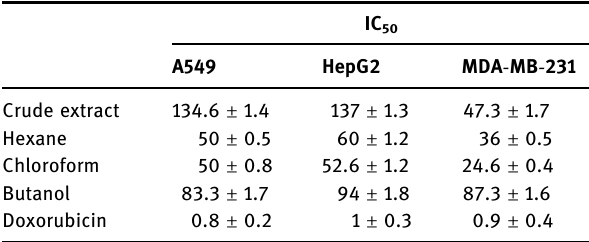
Table 3: Cytotoxic activity of D. viscosa fractions against various cancer cells